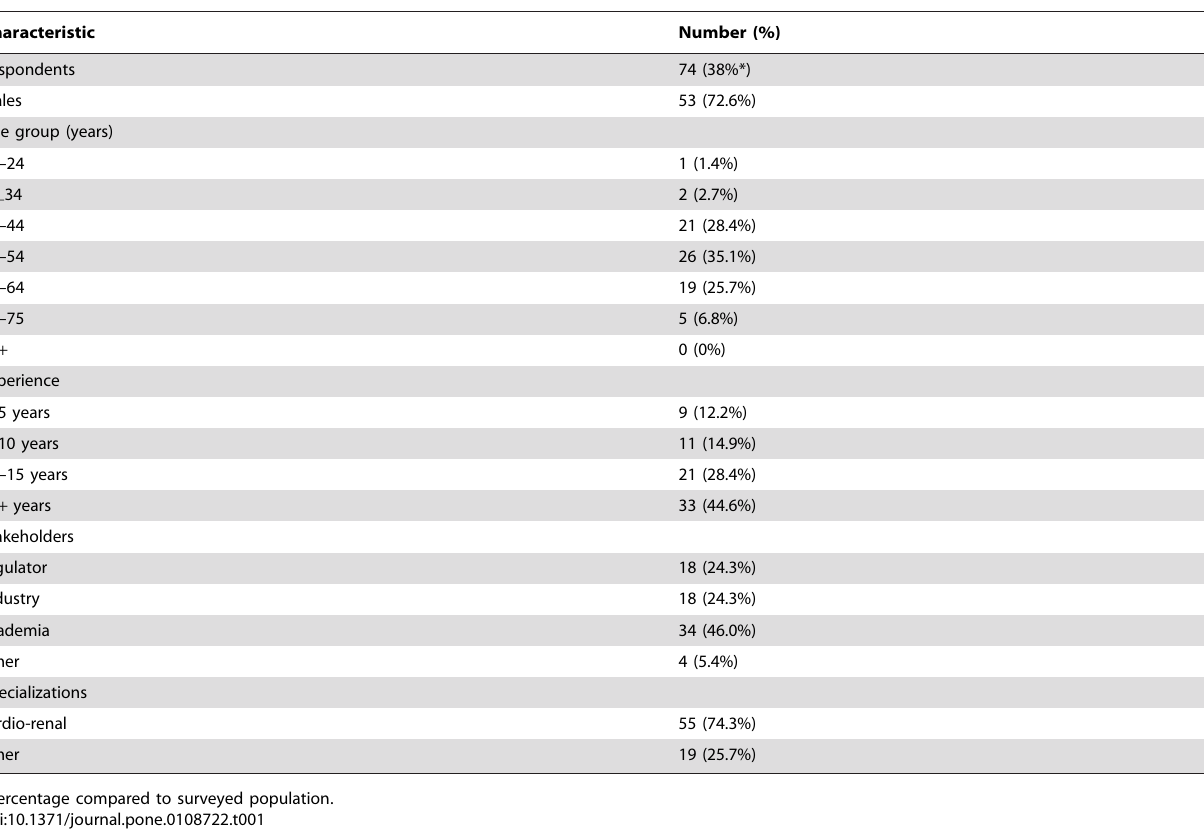
Table 1. Characteristics of respondents.